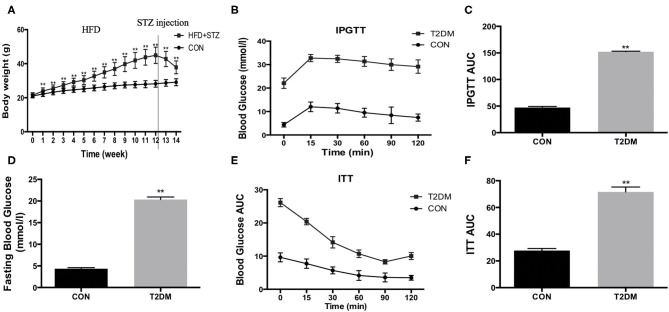
HFD/STZ induce the change of metabolic indexes in C57BL/6 mice. (A) Body weight, (B) Plots for glucose tolerance tests (IPGTT, 1 g/kg BW) in overnight fasted mice, (C) AUC values confirmed impairment of glucose tolerance in T2DM mice, (D) Fasting blood glucose, (E) Plots for insulin tolerance tests (ITT, 1IU/kg BW) in mice fasted for 6 h, (F) AUC values confirmed impairment of insulin tolerance in T2DM mice. All data are presented as mean ± SEM. *p < 0.05, **p < 0.01.